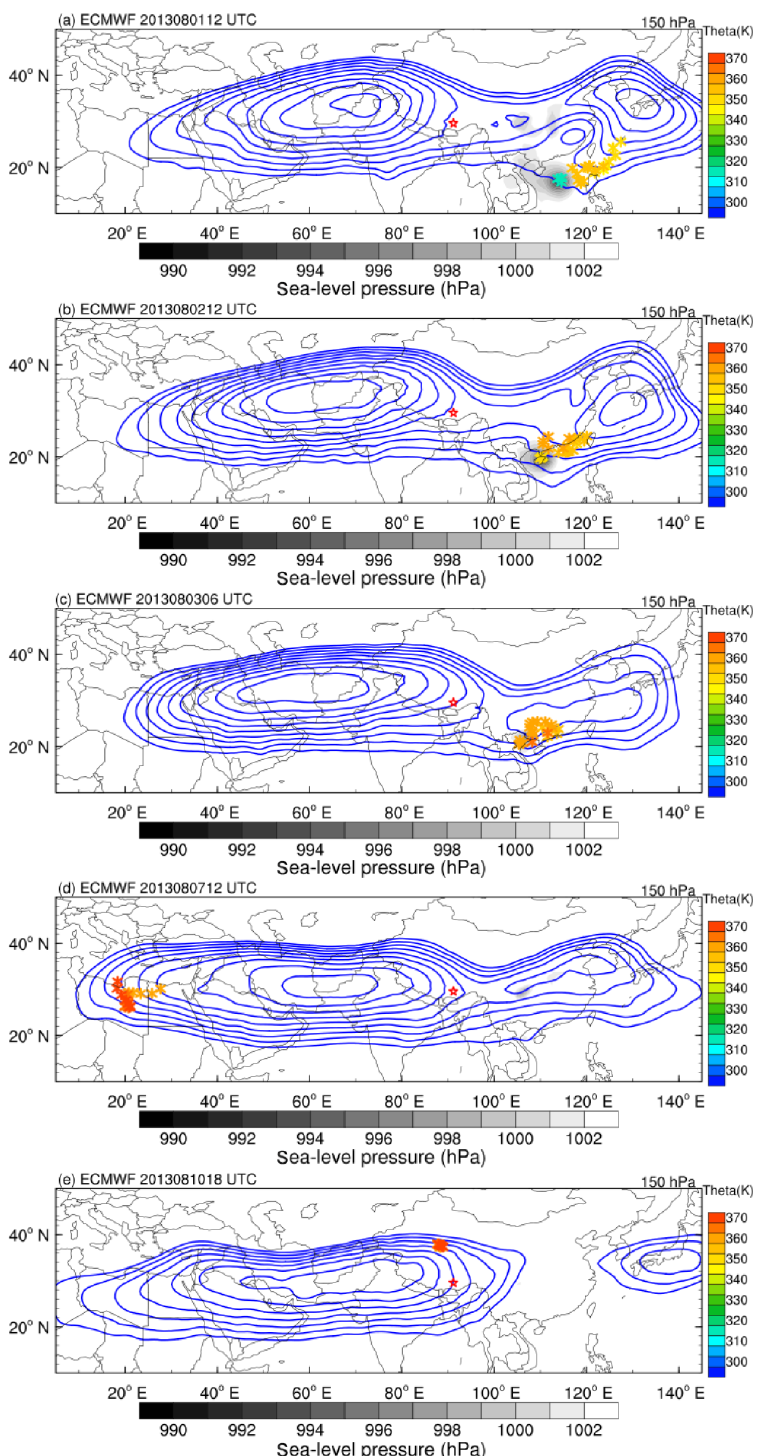
Figure 6. The same format as Fig. 5, but for Jebi. Here the geopotential height is shown at 150hPa pressure level.